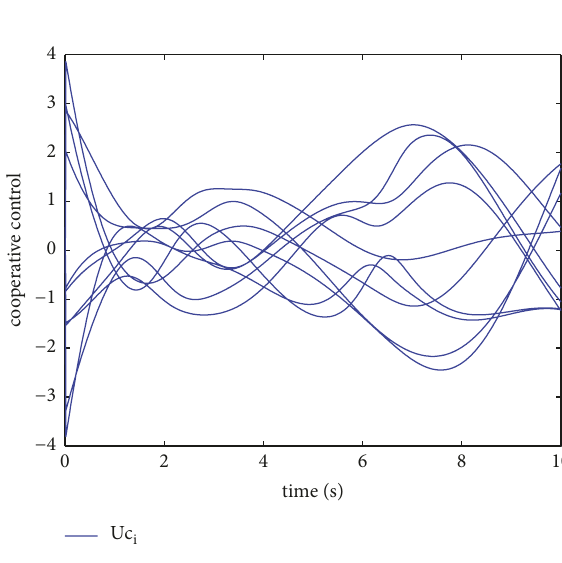
Figure 2: The trajectory of quadrotors.